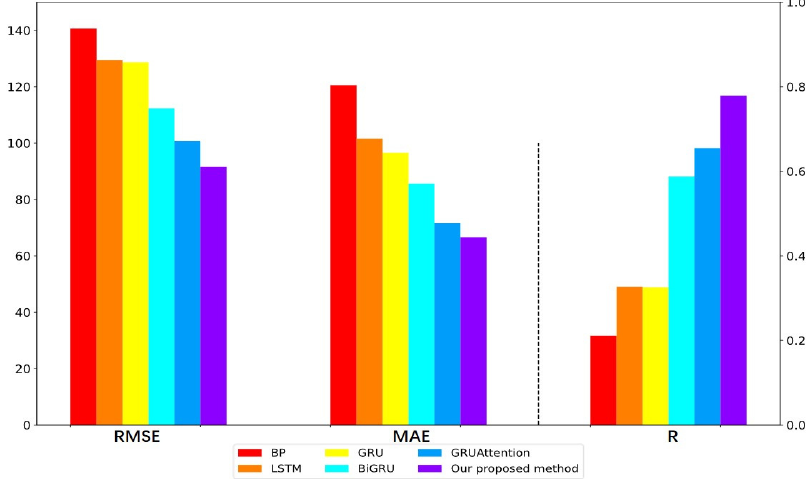
Figure 11. Model performance comparison based on light intensity data. Table 7. Comparison of model prediction performance based on light intensity data.